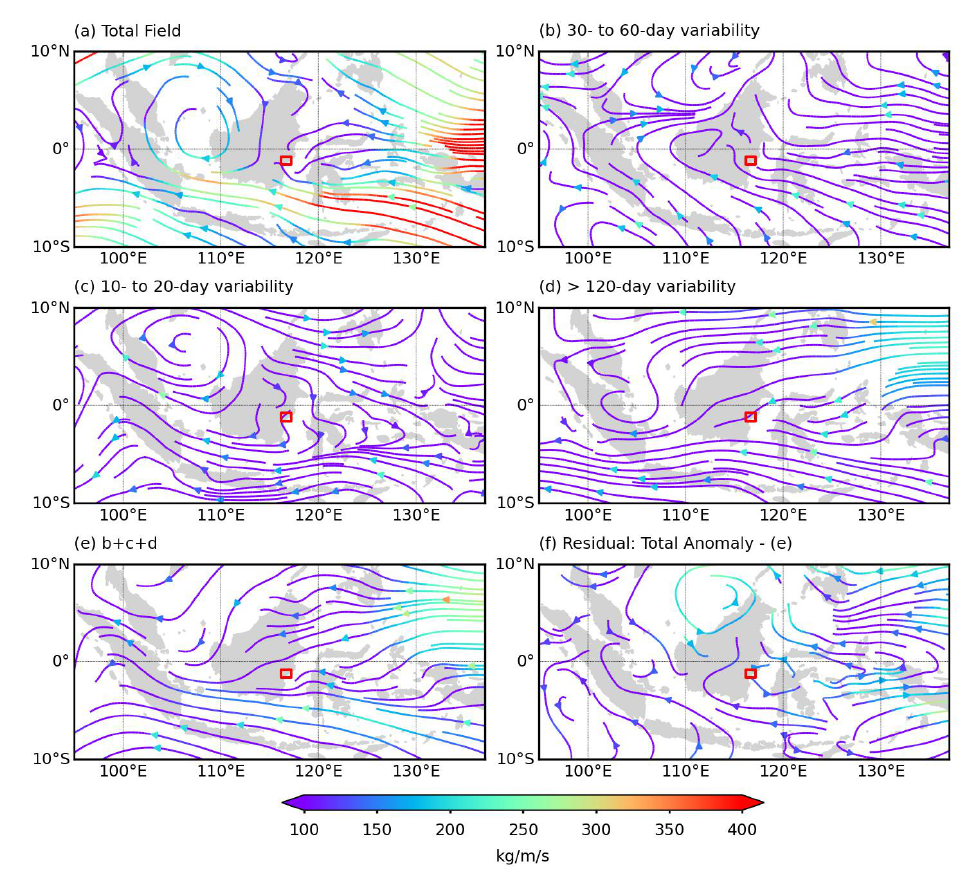
Figure 9. ( a ) The streamline of IVT during the period of extreme rainfall (27–28 August 2021) and its decomposition into contributions of ( b ) 30–60 day variability, ( c ) 10–20 day variability, ( d ) >120 day variability, ( e ) b + c + d, and ( f ) residual (total − (b + c + d). The streamlined colors denote the amplitude of IVT, and a red box denotes the location of